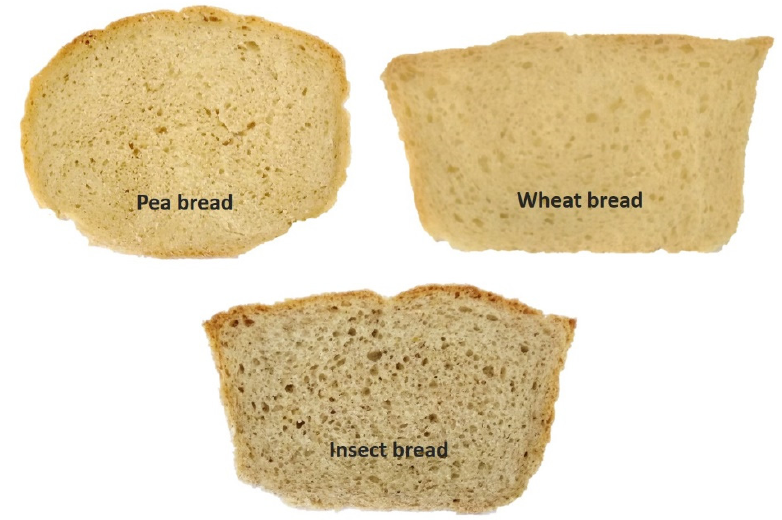
Figure 1. Stimulus presented to the respondent in an online questionnaire.